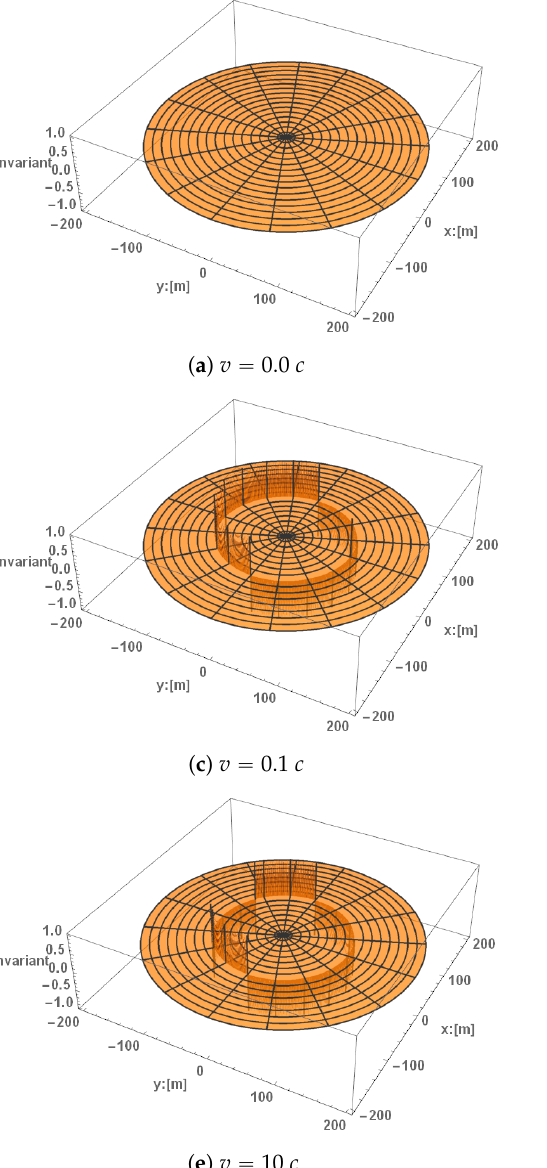
Figure A9. The velocity evolution of the w 2 invariant for the Natário warp drive at a constant velocity. The other parameters are set to σ = 50,000 1 and ρ = 100 m. Equation (11) is in natural units, so the speed of light was normalized out of the m equation. The factor of c was included in these captions to stress that the plots are of multiples of the speed of light. Their units are ms ´ 1